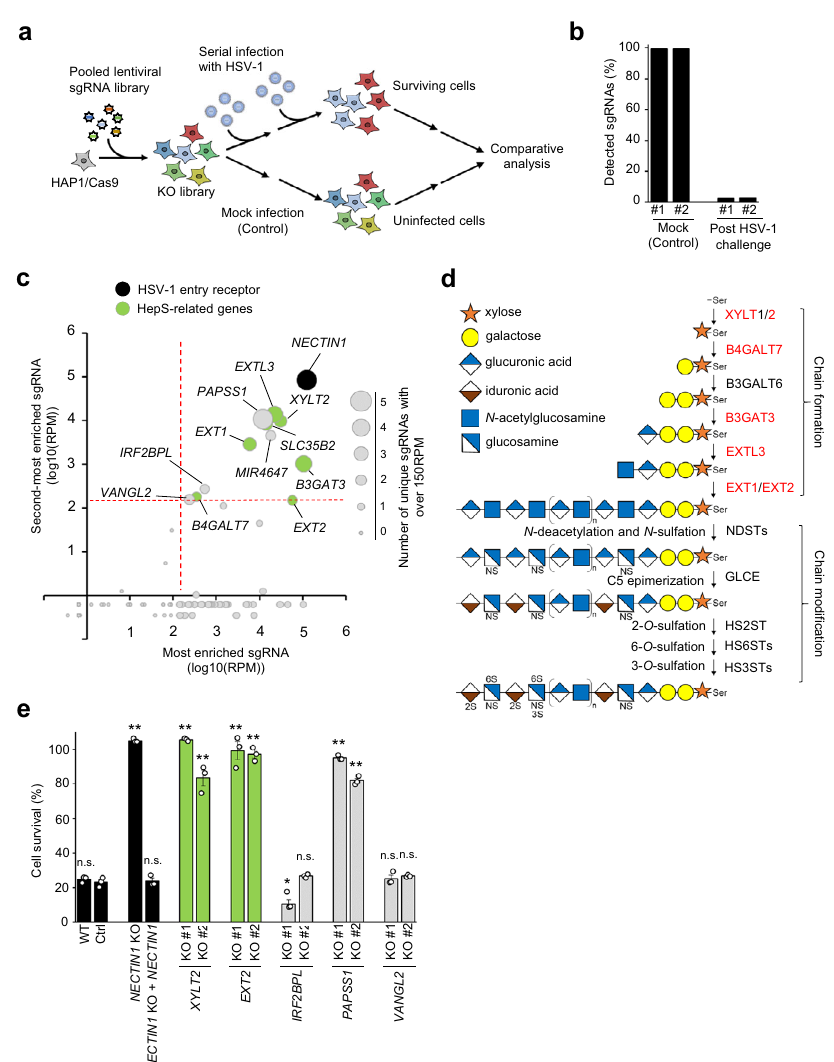
Fig. 1 Genome-wide CRISPR screen to identify genes involved in HSV-1 infection. a Schematic representation of the CRISPR-based KO screening process. HAP1/Cas9 cells were mutagenized with a pooled lentiviral single-guide RNAs (sgRNA) library containing 121,449 unique sgRNAs targeting 19,052 genes and 1864 miRNAs. Mutant cells were infected with HSV-1, following which the viral infection-resistant cells were harvested. The control groups were mock-infected with PBS and cultured for the same period. The abundance of each sgRNA in the control and selected groups was determined through next-generation sequencing. This screening was performed in duplicate at an estimated coverage of 150 cells/sgRNA. b Abundance of sgRNAs in the mock-infected control and HSV-1-infected groups. c Scatter plot showing the most enriched sgRNA (log-transformed RPM: X-axis) versus the second- most enriched sgRNA (log-transformed RPM: Y-axis) for each gene following selection by HSV-1 infection. The size of the plots indicates the number of unique sgRNA detected with >150 RPM. Genes supported by ≥ 2sgRNAs with >150 RPM (red lines) were selected for further validation. d Overview of HepS biosynthesis. Genes supported by two or more sgRNA with over 150 RPM on our screen are highlighted in red font. e Validation of candidate genes. One or two KO HAP1 clones of the indicated genes were obtained by the CRISPR-Cas9 system. The wildtype (WT), nontargeting control (Ctrl), and KO clones were infected with HSV-1at a MOI of 3, and the cell viabilities were measured at 48 hpi via the MTS assay. The results are presented as means ± SEM of three independent experiments. Asterisks, p < 0.05; Double asterisks, p < 0.01; n.s. not signi fi